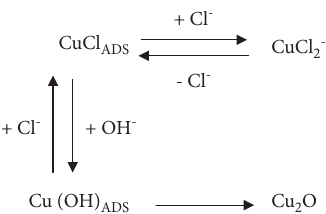
Figure 4: Formation of Cu 2 O in chloride solution